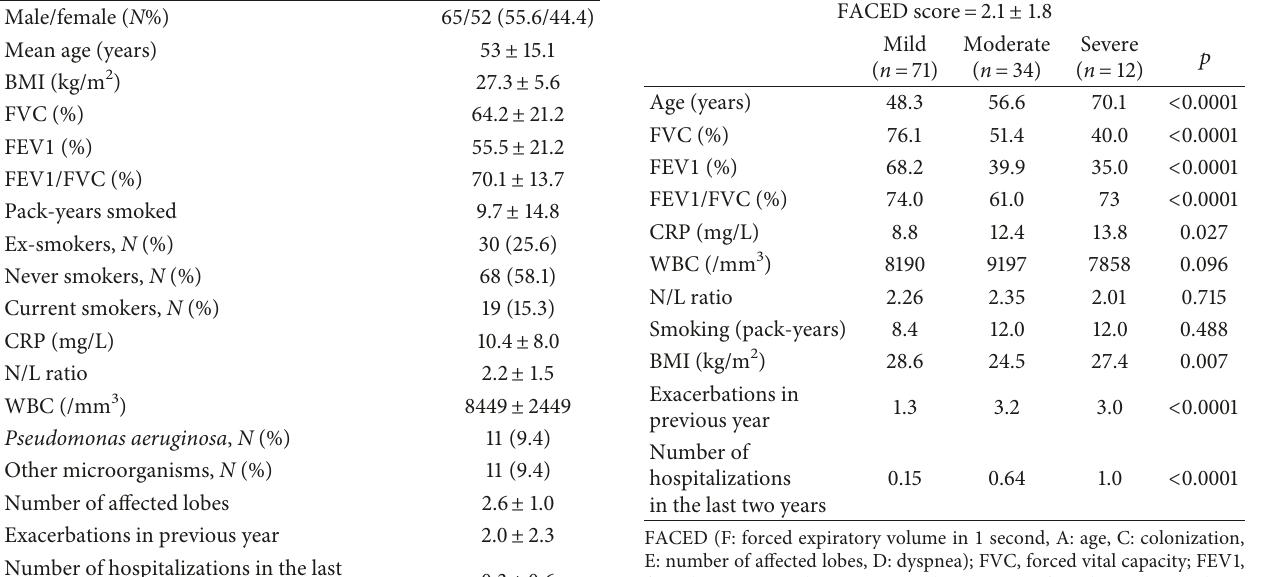
Table 1: Characteristics of the study participants. Characteristics